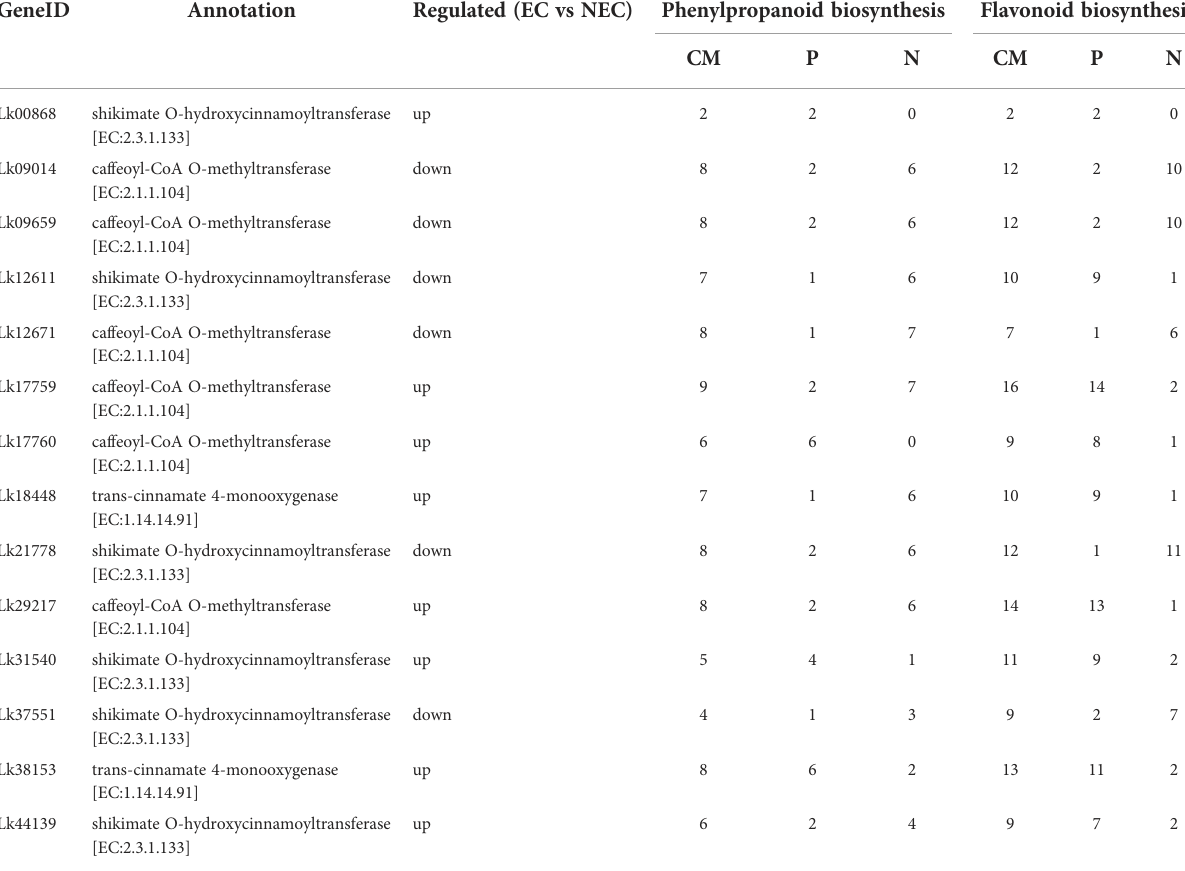
TABLE 3 Co-regulated DEGs and their relationship with DAMs in phenylpropanoid and fl avonoid biosynthesis pathway. GeneID